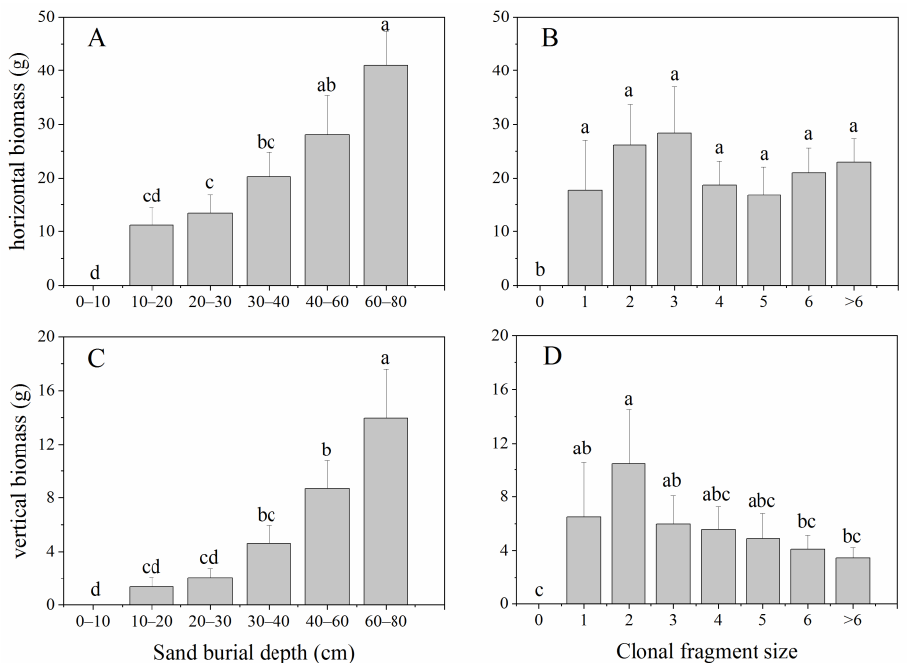
Figure 2. The effects of sand burial depth and clonal fragment size on the horizontal ( A , B ) and vertical biomass ( C , D ) (mean ± SE) of P. communis . Different letters indicate significant differences in biomass among different sand burial depths and/or clonal fragment sizes at the p < 0.05 level.